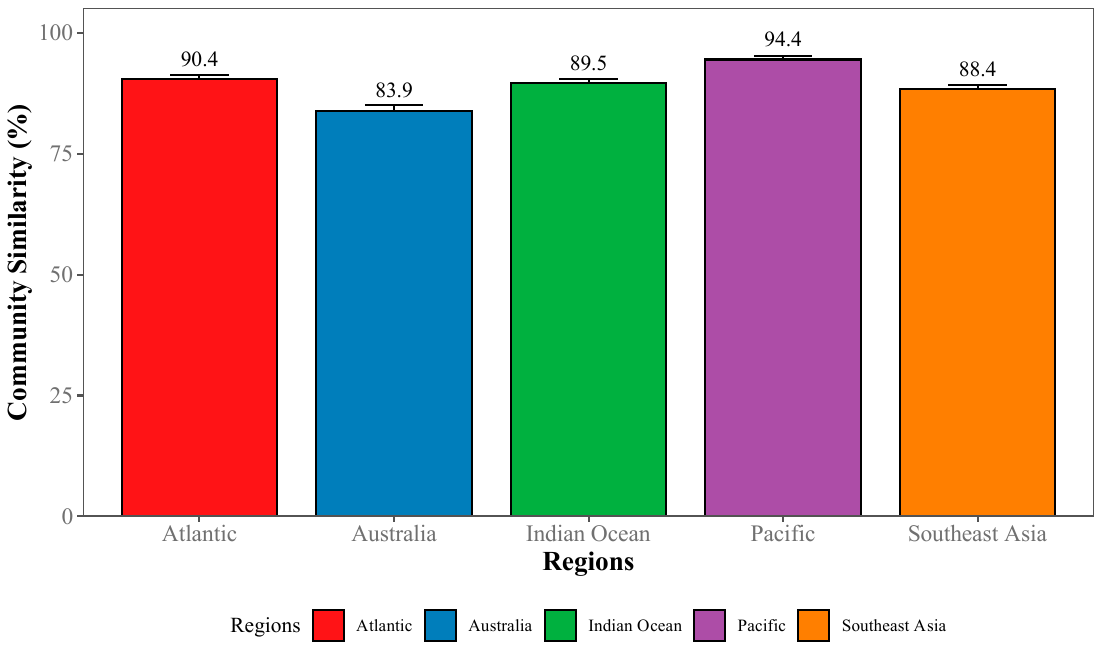
Figure 5. Performance of automated estimations of benthic composition in terms of compositional similarity. Community similarity between observed and estimated benthic composition per region evaluated by the Bry-Curtis similarity index. Solid and error bars represent the mean and 95% Confidence Intervals of the error, respectively.